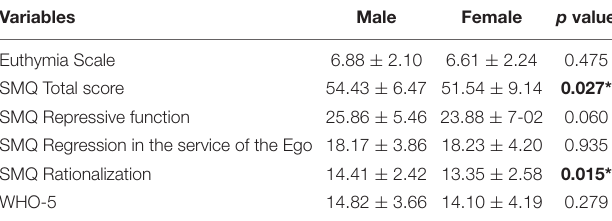
TABLE 4 | Comparison between male and female